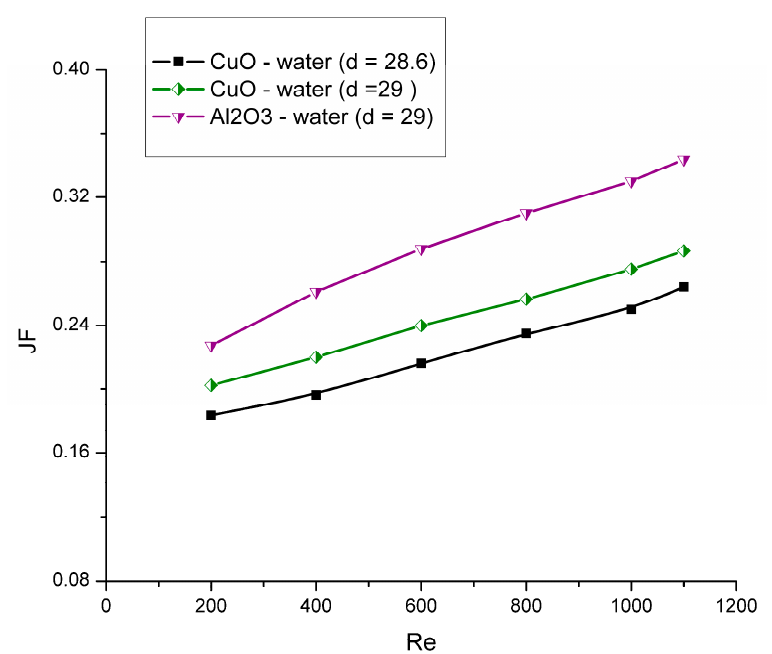
Figure 14. The effect of different nanoparticles and Reynolds number on the JF factor.